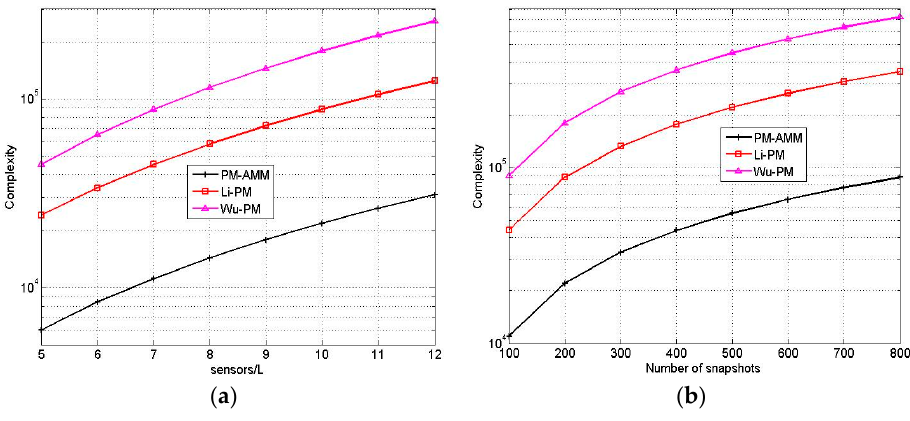
Figure 2. Complexity comparison of three algorithms. ( a ) T = 200; ( b ) L = 10.